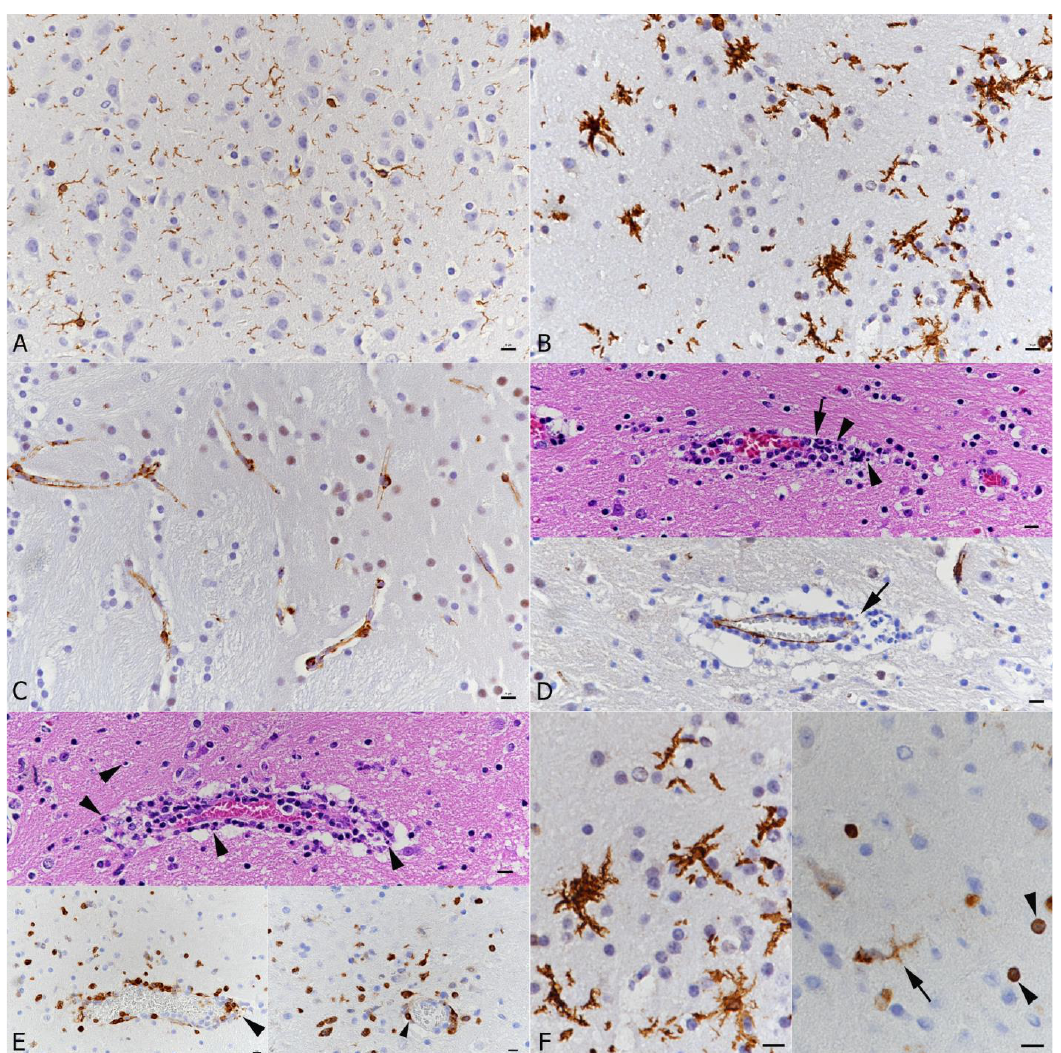
Figure 5. Brain, K18-hACE mice, mock infected and at day 7 post-intranasal SARS-CoV-2 Pango lineage B infection (10 4 PFU) after initial infection with IAV (10 2 PFU IAV strain A/X31). ( A ) Mock infected mouse. Quiescent microglia (Iba1+). ( B ) Infected animal. Diffuse microglial activation (Iba1+ stellate cells). ( C ) Mock infected mouse. Endothelial cells show cytoplasmic ACE2 expression. ( D – F ) Infected animal. ( D ) Vessel with moderate leukocyte infiltration with focal destruction of the vessel wall (arrows) and some degenerate leukocytes (leukocytoclastic component). Top: HE stain; bottom: staining for ACE2, showing disruption of the endothelial cells layer. ( E ) Vessel with mod- erate leukocyte infiltration (top: HE stain; bottom: staining for cleaved caspase 3). Individual cells in the infiltrate and in the adjacent parenchyma (top and bottom left: arrowheads) and endothelial cells in an affected vessel (bottom right: arrowhead) undergo apoptosis. ( F ) Activated microglia (Iba1+; left). Staining for cleaved caspase 3 (right) shows apoptosis of a microglial cell (arrow) and of small round cells (arrowheads; morphology consistent with lymphocytes). ( A – E ) bars = 20 μm; ( F ) bars = 10 μm . 4. Discussion